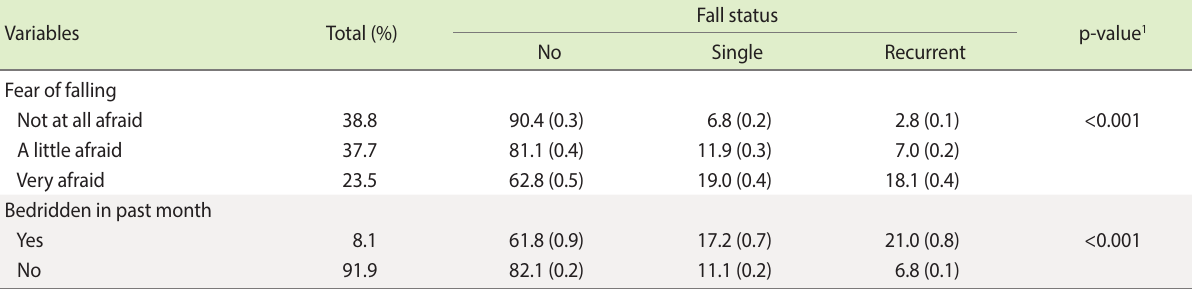
Table 2. Fall-related characteristics according to fall status in adults aged 65 and older